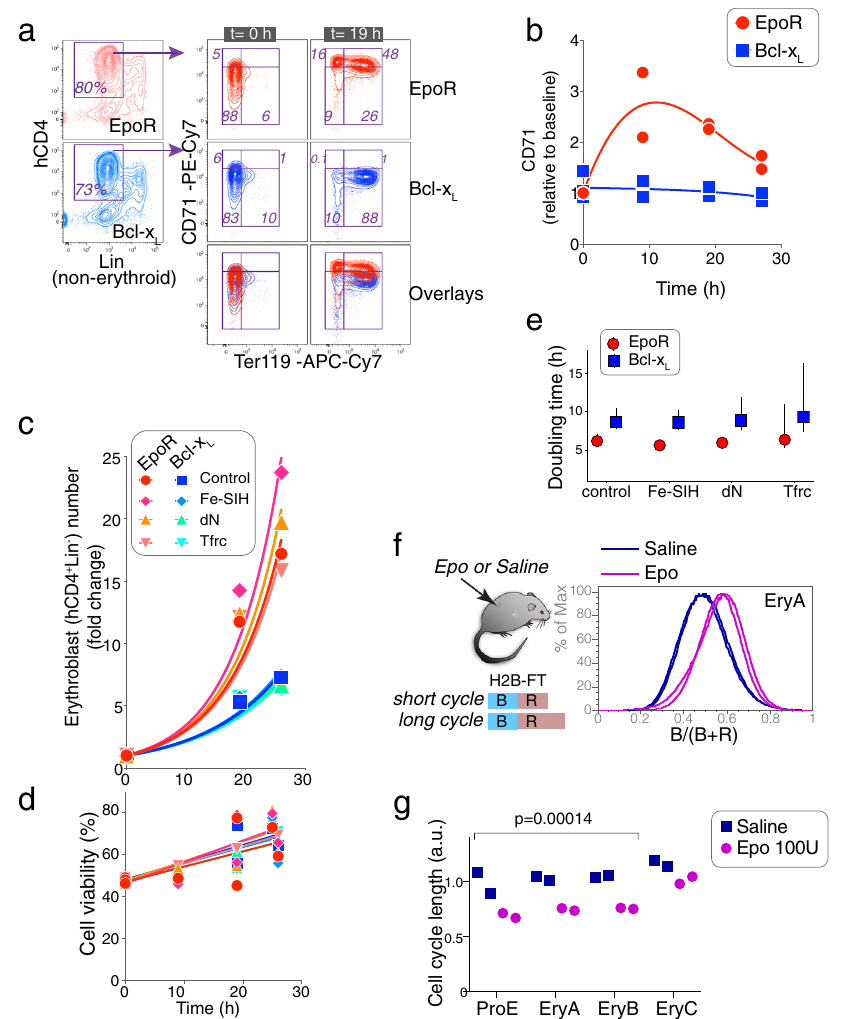
Fig. 2 EpoR stimulates cell-cycle shortening in early erythroblasts in vitro and in vivo. a The EpoR is required for CD71 upregulation. Epor − / − fetal livers were transduced with either EpoR or Bcl-x L retroviral vectors carrying the hCD4 reporter (see Supplementary Fig. 2b for experimental design). Transduced cells (hCD4 + Lin − ) were examined for expression of CD71 and Ter119. b Time course of CD71 expression following transduction as in ( a ). MFI; median fl uorescence intensity, relative to t = 0; n = 2 independent experiments. c Growth of Epor − / − fetal liver cells transduced with either Bcl-x L or EpoR. Viable hCD4 + Lin − cells were counted at the indicated times. Fe-SIH (10 μ M) or deoxynucleosides (dN, 0.7 μ M) were added to the medium as indicated. ‘ Tfrc ’ cells were doubly transduced with both Tfrc , and either Epor or Bcl-x L . Data, pooled from n = 4 independent experiments and expressed relative to cell number at t = 0, were fi t with exponential curves ( R 2 values 0.8 – 0.94, least-squares fi t). d Trypan blue negative cells, for the set of experiments in ( c ). e Cell doubling times ±95% con fi dence intervals, calculated from the fi tting of exponential growth curves to the data in ( e ). f Cell-cycle shortening in early erythroblasts in vivo. Mice transgenic for the chimeric histone H2B- fl uorescence-timer protein (H2B-FT) were injected with either saline or Epo (100 U) at 0 and 24 h. Bone marrow was analyzed at 36 h. H2B-FT fl uoresces blue ( ‘ B ’ ) for 1 – 2 h immediately following synthesis, and matures into a red fl uorescent protein ( ‘ R ’ ). The ratio of blue to total fl uorescence ( B /( B + R )) is a function of cell-cycle length 27 . Shown are histograms of B /( B + R ) in EryA erythroblasts (Ter119 high CD71 high FSC high ). Histogram overlays are for n = 2 mice injected with either saline or Epo. g Relative cell-cycle lengths for the 4 mice analyzed in ( f ), for each of the indicated erythroblast maturation stages: ProE (Ter119 med CD71 high ), EryA (Ter119 high CD71 high FSC high ), EryB (Ter119 high CD71 high FSC low ), EryC (Ter119 high CD71 low FSC low ). p -value is for a two-tailed paired t test, pairing Epo-injected and Saline-injected mice for each erythroblast stage (ProE and EryA/B/C). Late erythroblasts (EryC) may divide, but their cell cycle is no longer sensitive to Epo